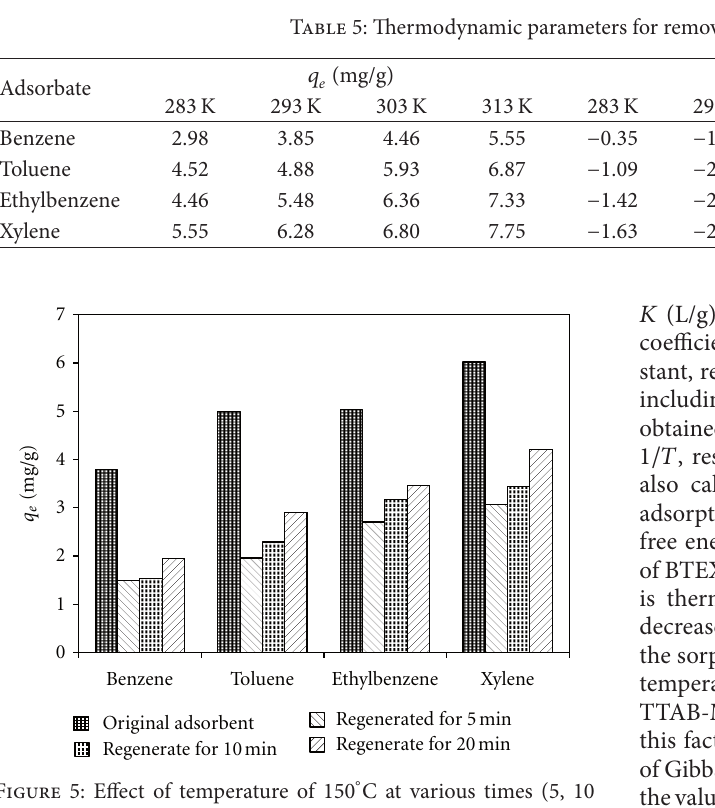
C at various times (5, ∘